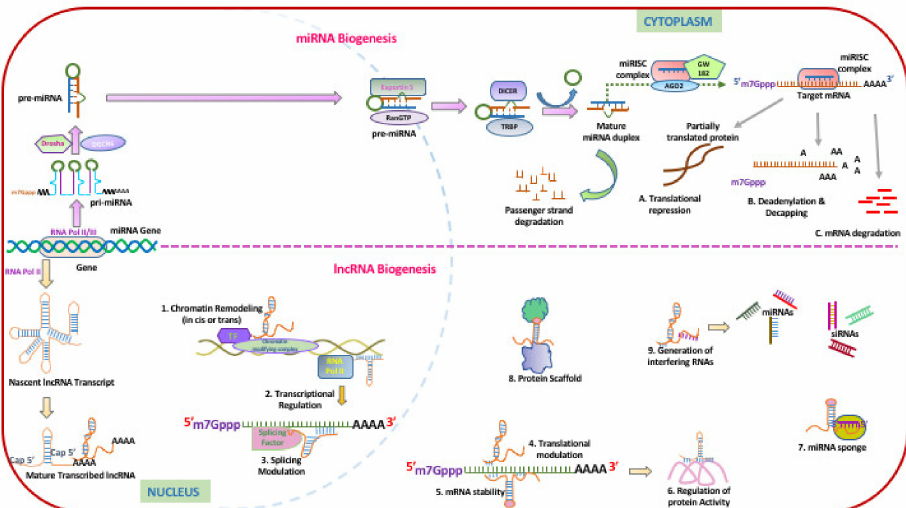
Figure 2. miRNAs and lncRNAs biogenesis and their role in epigenetic, transcriptional and posttranscriptional regulation. MiRNAs are short, single-stranded endogenous non-coding RNAs, of about 22 nucleotides that post-transcriptionally regulate gene expression. Most of the miRNA coding genes are found in introns and some are located as independent single transcriptional units or in clusters. miRNAs are involved in nearly all normal and developmental and pathological processes in